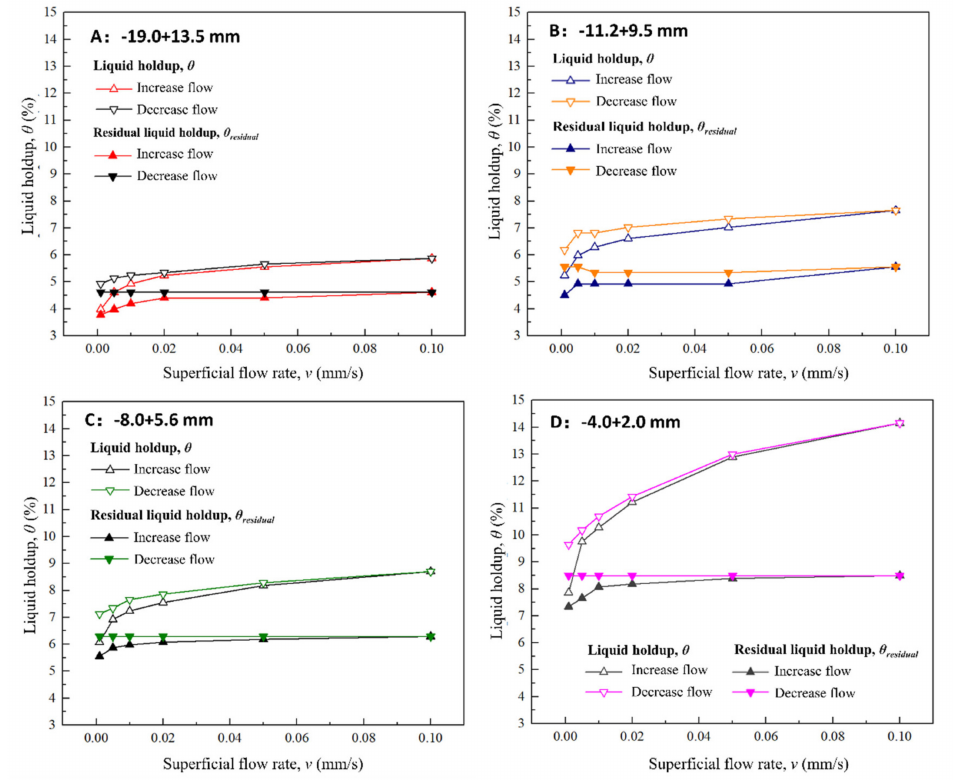
Figure 6. Changes of residual liquid holdup during increase/decrease flow rate arm of stepwise irrigation condition. ( A ): − 19.0 + 13.5 mm; ( B ): − 11.2 + 9.5 mm; ( C ): − 8.0 + 5.6 mm; ( D ): − 4.0 + 2.0